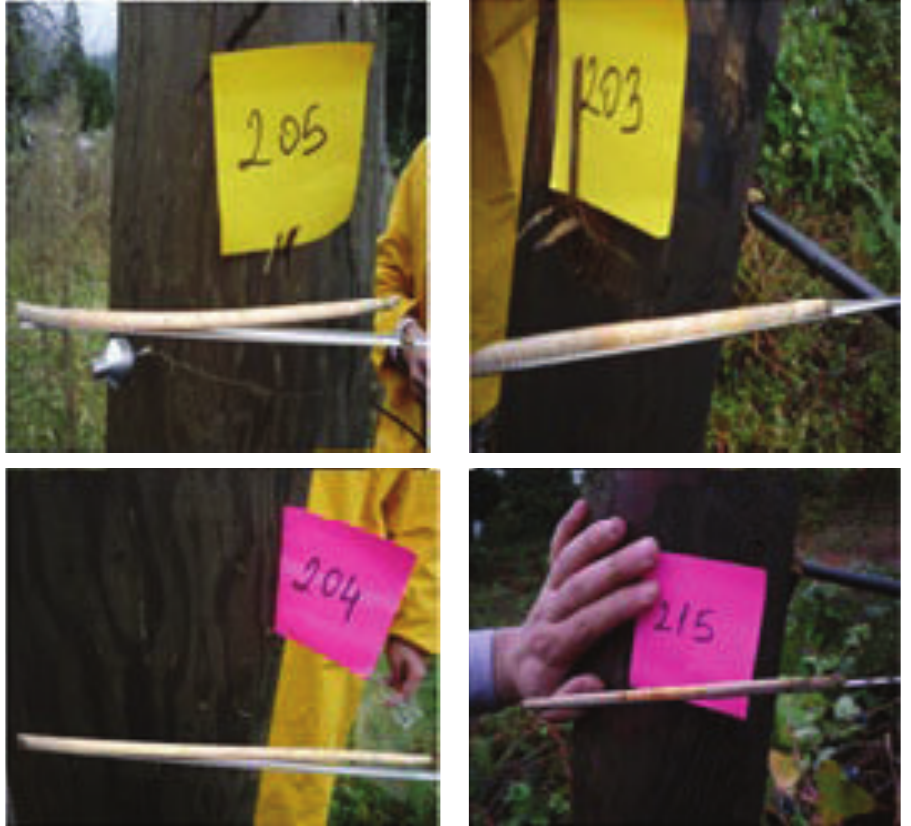
Figure 9: Penetration of wood preservatives in utility